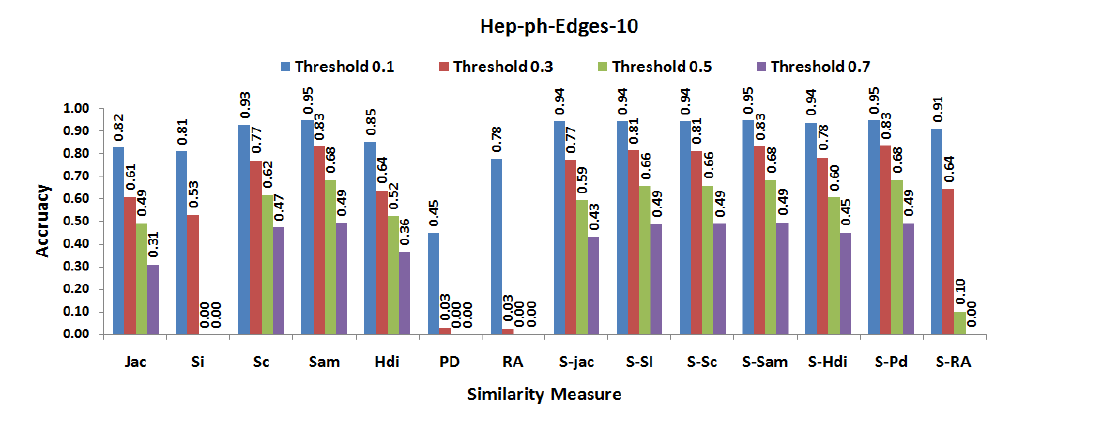
Figure 9. Prediction Results using HepPh Dataset with 10% Edges